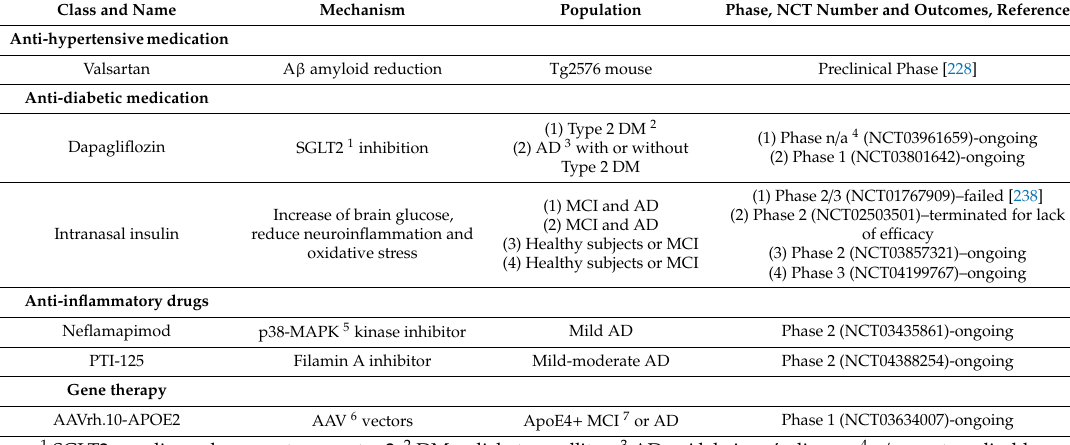
Table 3. Therapeutics targeting modifiable risk factors for